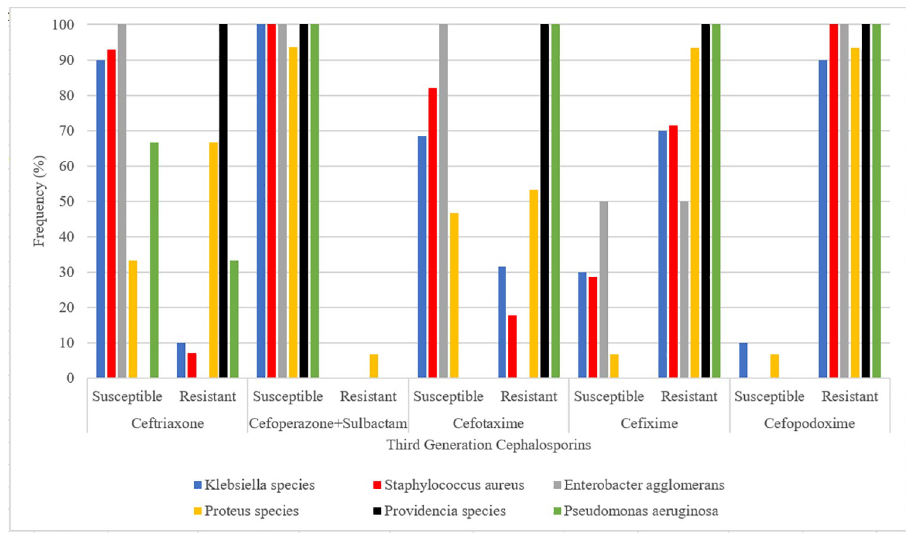
Fig 1. Overall susceptibility profile of infected chronic wound isolates against selected third generation cephalosporins.